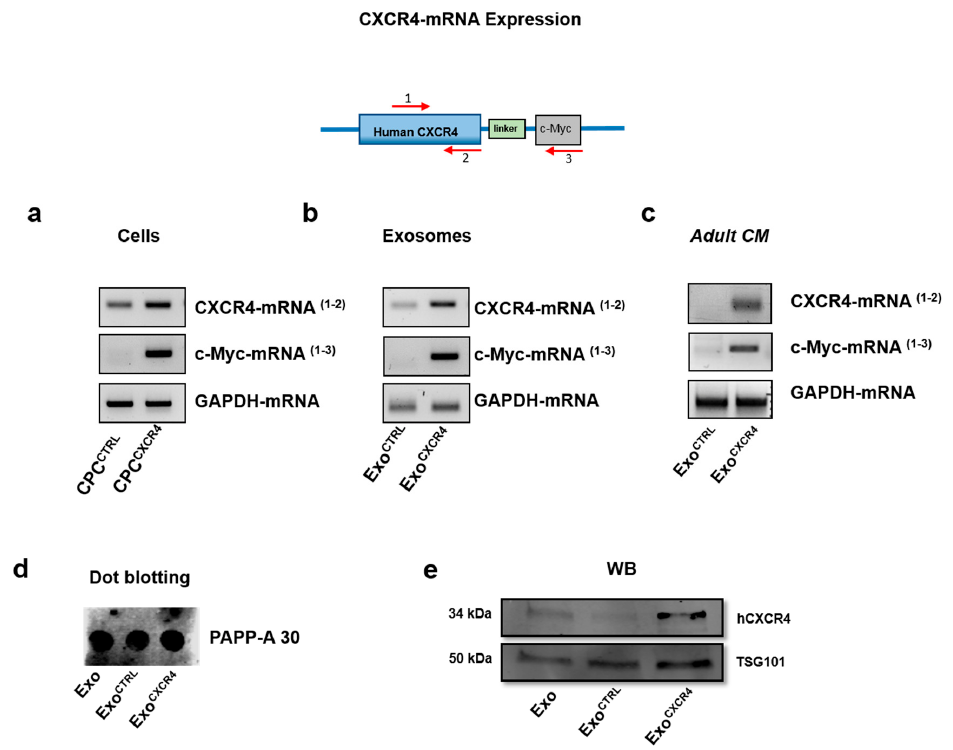
Figure A1. CXCR4-mRNA expression. ( a ) Conventional RT-PCR showing the presence of CXCR4 mRNA in cells before and after transfection (CPC CTRL vs. CPC CXCR4 ). The exogenous sequence (c-Myc) is only present into transfected cells (CPC CXCR4 ). ( b )The hCXCR4-mRNA is slightly present in Exo CTRL and its expression increases in Exo produced by transfected cells (Exo CXCR4 ). The sequence of c-Myc